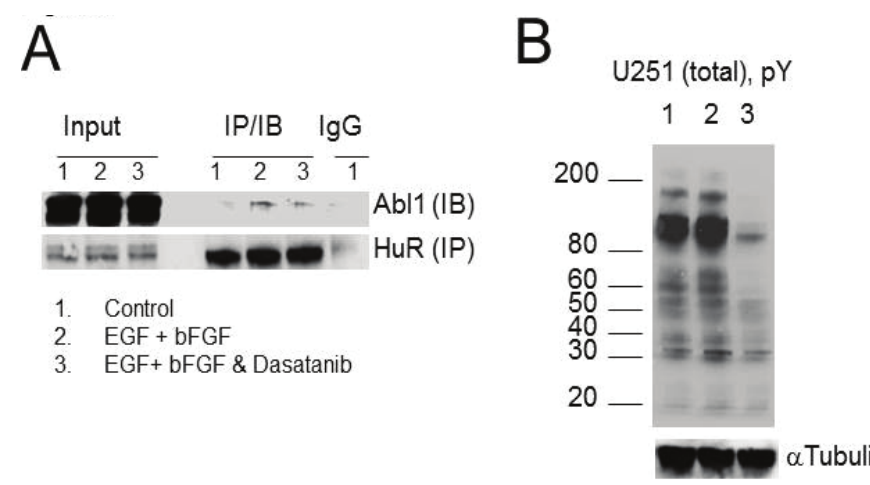
Figure 6. The interaction of HuR and Abl-1 kinase is growth factor dependent. ( A ) Immunoblotting for Abl-1 kinase co-immunoprecipitated with HuR from cells in the control condition, after treatment with growth factors, or growth factors in the presence of